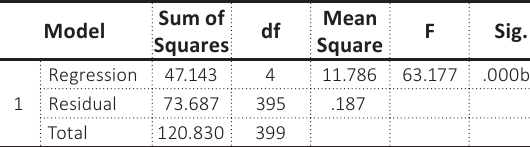
Table 4. Analysis of variance for H1 (ANOVA)